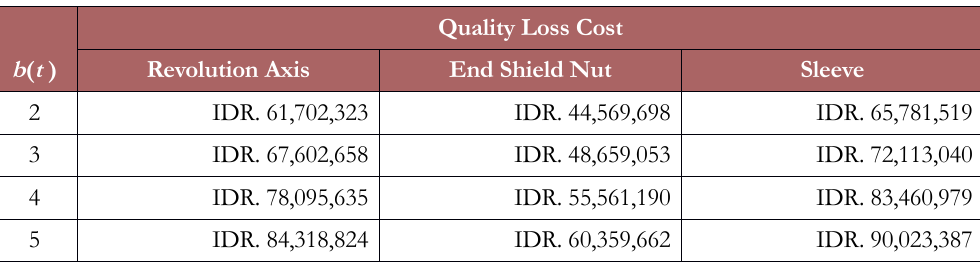
Table 25. Effects of interruption time to the quality loss